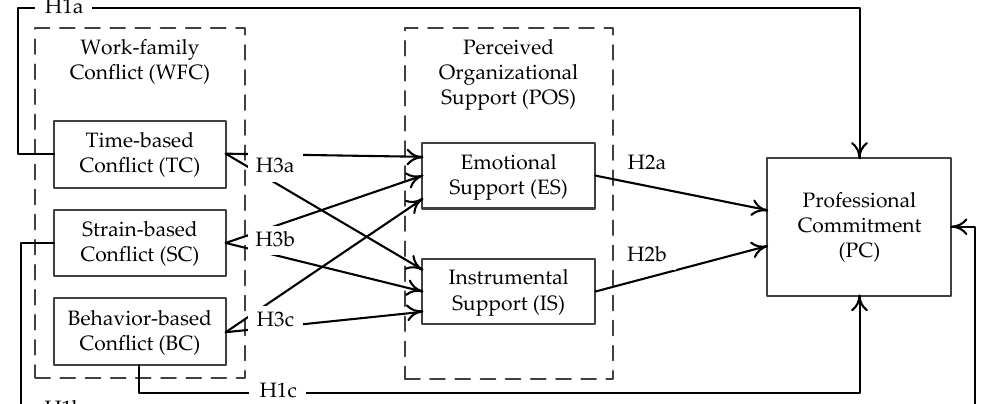
Figure 1. The conceptual model.